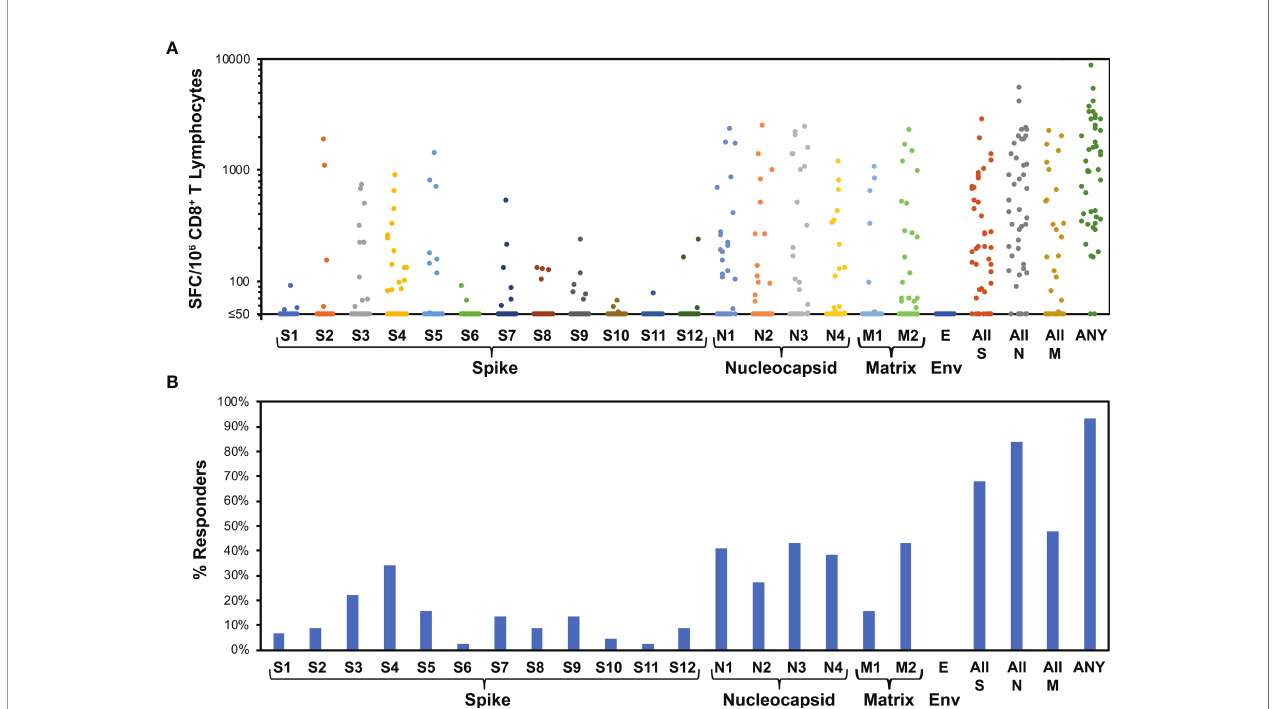
FIGURE 3 | Evaluation of CD8 + T cell targeting of SARS-CoV-2 by ELISpot using peptide pools demonstrates broad targeting of spike, nucleocapsid, and matrix, with dominance of nucleocapsid targeting. For 44 persons after recent SARS-CoV-2 infection (36 with mild infection, 8 with severe infection, mean 31.1 days, range 11 to 47 days after symptom onset), IFN- g ELISpot was performed on polyclonally expanded CD8 + T cells using peptides spanning spike, nucleocapsid, matrix, and envelope proteins, which were combined in pools of 16 or fewer ( Supplementary Table 1 ). Spike was contained in 12 pools (S1 to S12), nucleocapsid in four pools (N1 to N4), matrix in two pools (M1 to M2), and envelope in one pool (E). (A) Frequencies of responses against each pool are plotted for each participant. The mean total responses against spike, nucleocapsid, matrix, and envelope were 396 SFC/million CD8 + T cells, 901 SFC/million CD8 + T cells, 296 SFC/million CD8 + T cells, and 0 SFC/million CD8 + T cells, respectively. (B) Percentages of persons responding against each pool are plotted. Targeting of spike, nucleocapsid, matrix, and envelope was an average of 1.4, 1.5, 0.6, and 0.0 peptide pools per person, respectively. Response against pools S4 and S5, comprising the receptor binding domain of spike, was an average 0.5 peptide pools per